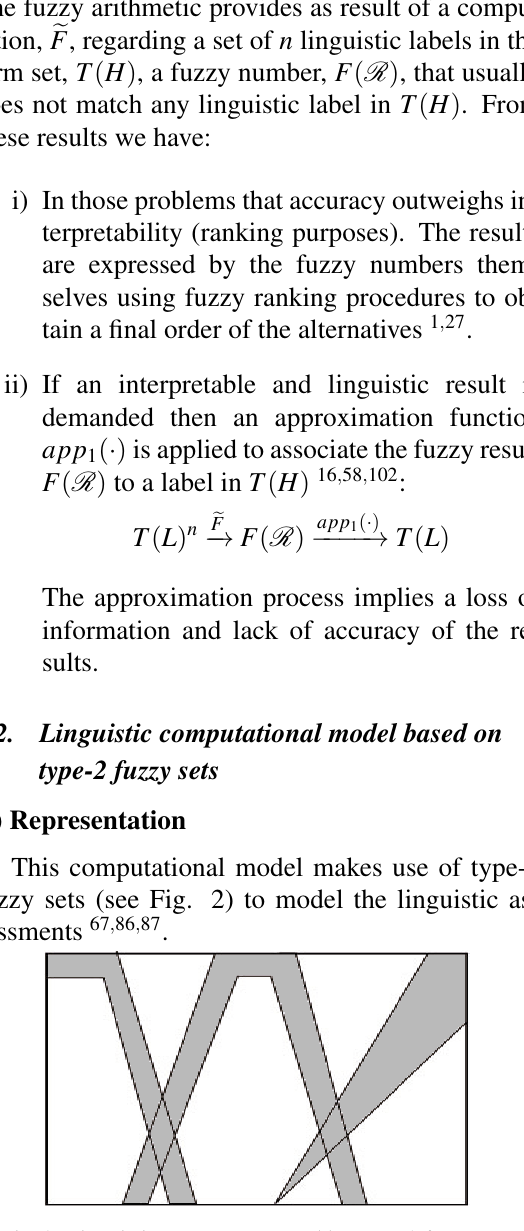
Fig. 2. Linguistic terms represented by Type-2 fuzzy